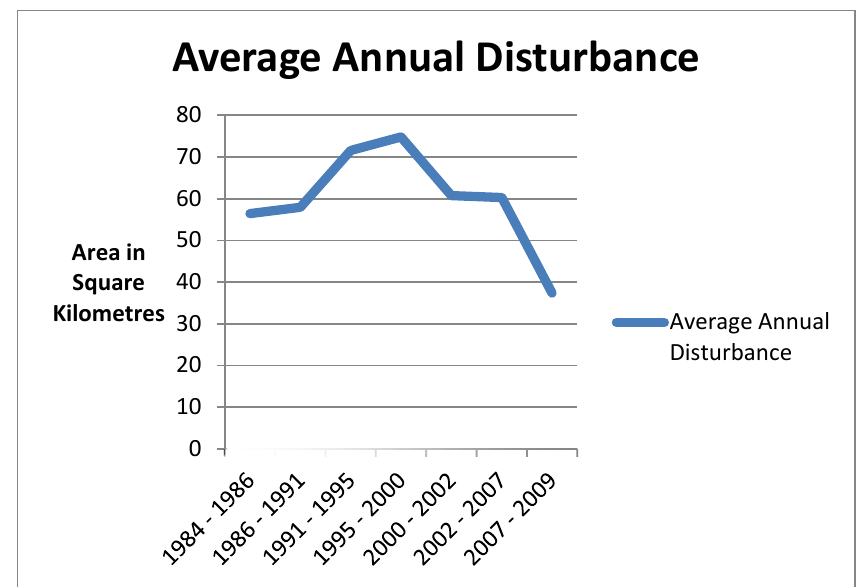
Figure 6. Average annual disturbance (area in km 2